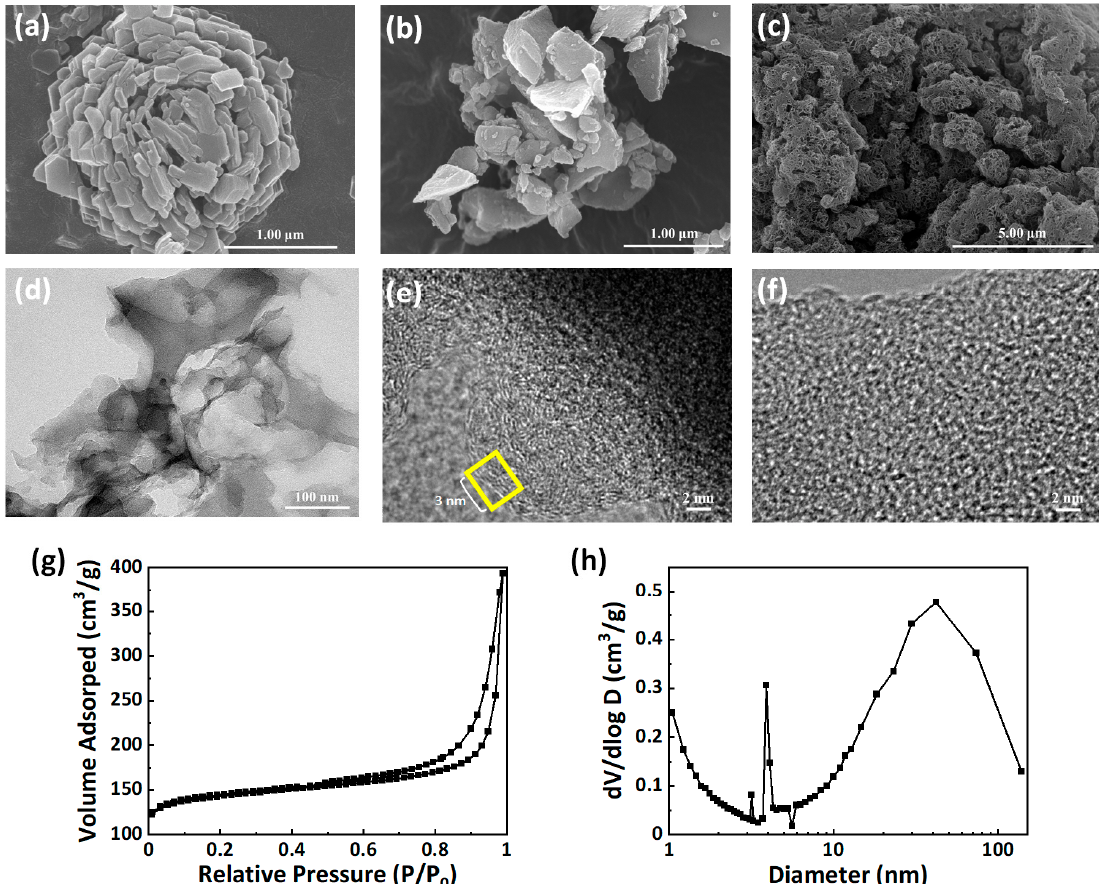
Figure 1. Scanning electron microscope (SEM) images of ( a ) MCA, ( b ) GLC, ( c ) MGC, transmission electron microscope (TEM) images of ( d , e ) MGC, ( f ) GLC, N 2 adsorption–desorption results of MGC ( g ) isotherm profile and ( h ) Barrett-Joyner- Halenda (BJH) desorption pore size distribution.